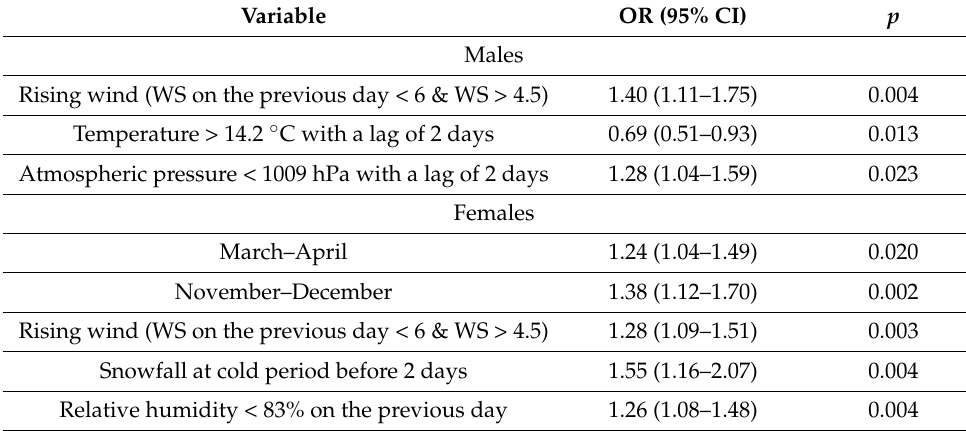
Table 3. The risk of depressive symptoms depending on meteorological factors according to sex (adjusting for